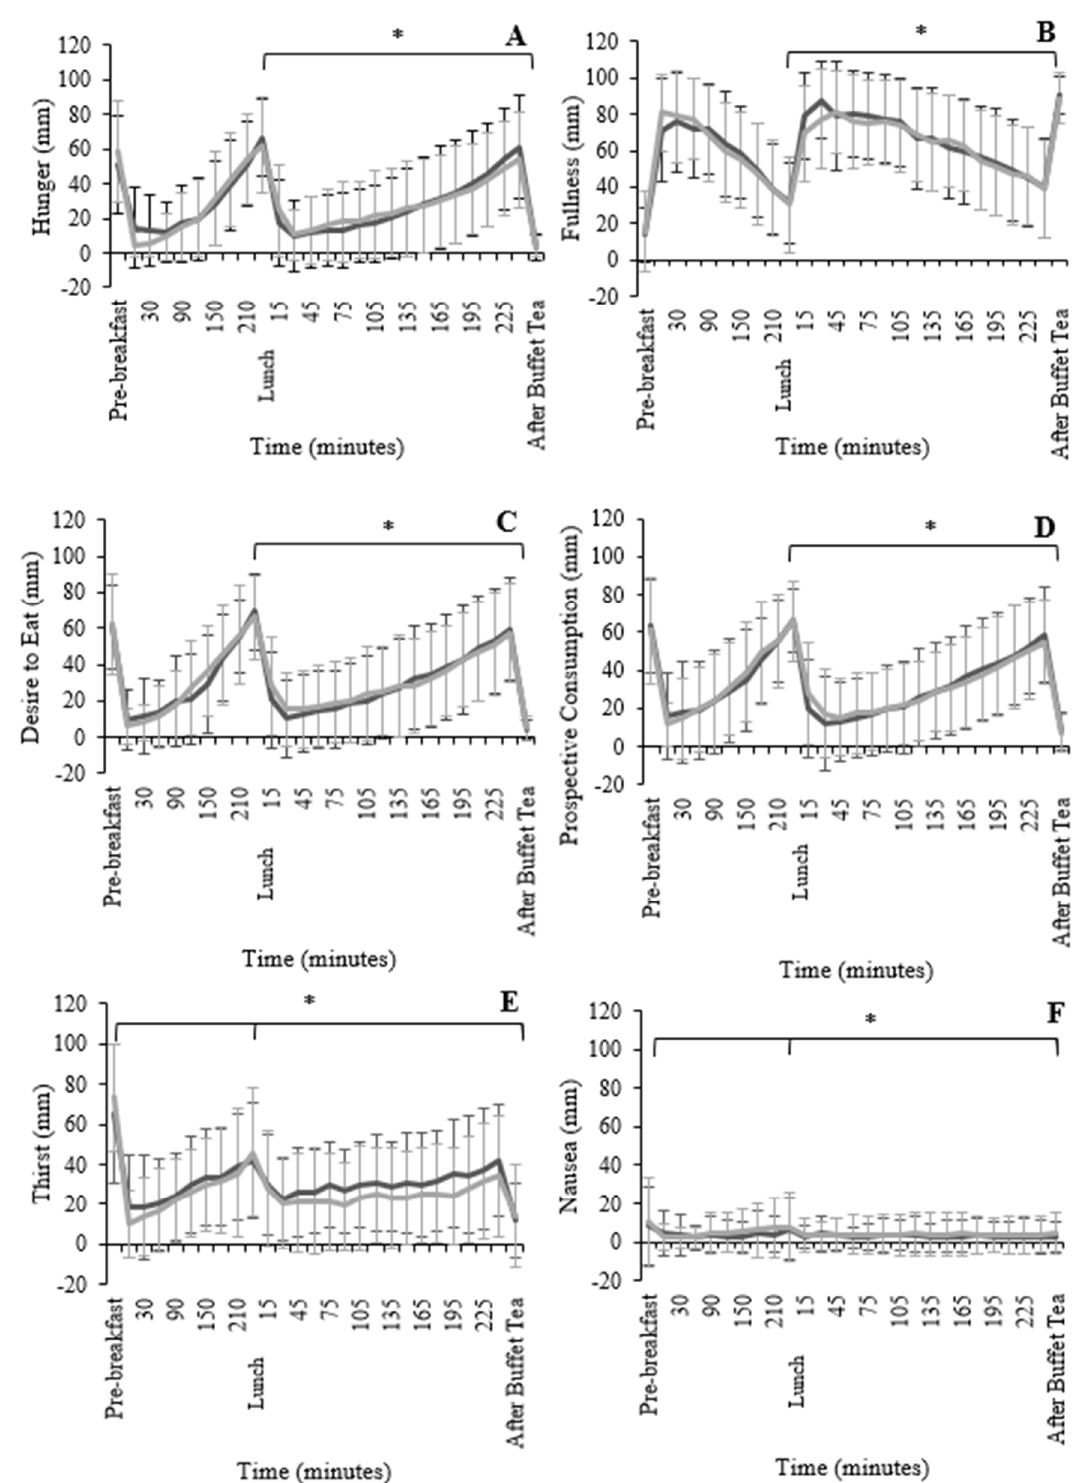
Figure 3. Mean ( ± standard deviation) for hunger ( A ), fullness ( B ), desire to eat ( C ), prospective consumption ( D ), thirst ( E ), and nausea ( F ) from VAS taken throughout the HEDRM test day (black) and the LEDRM test day (grey). Significance tested by analysis of variance (ANOVA) using baseline values as covariate. * Indicates significant difference between test meals.